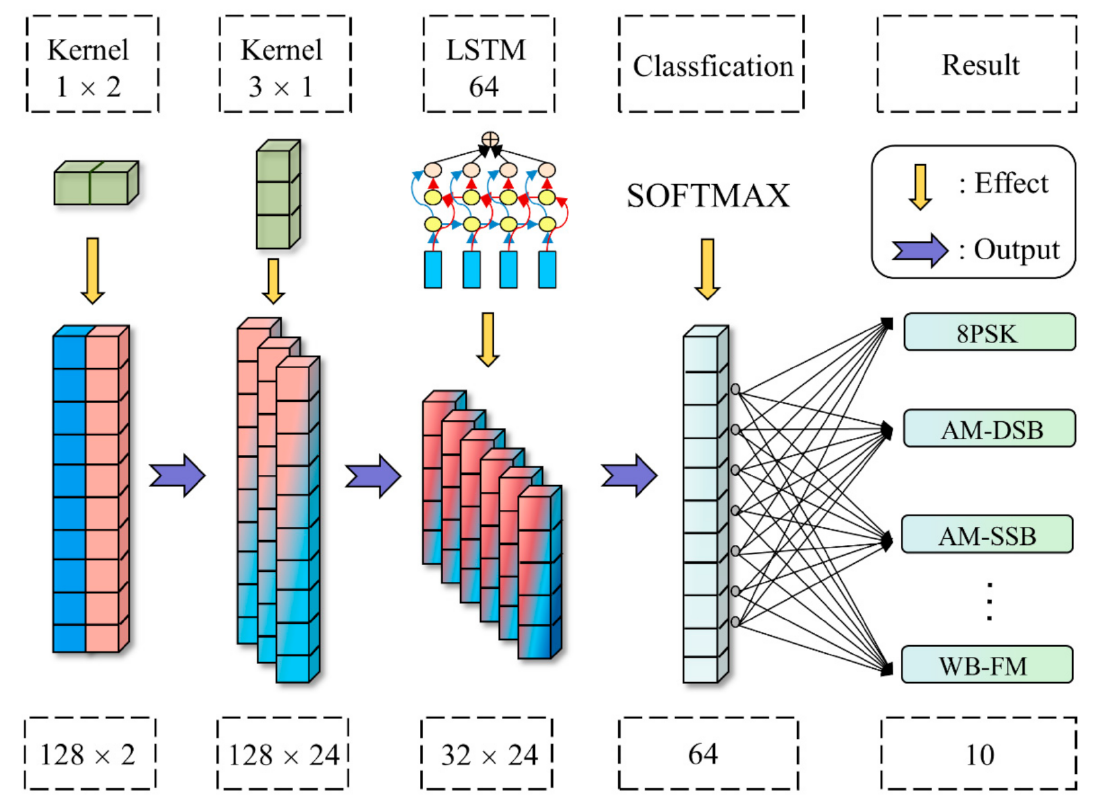
Figure 3. IQCLNet network model.